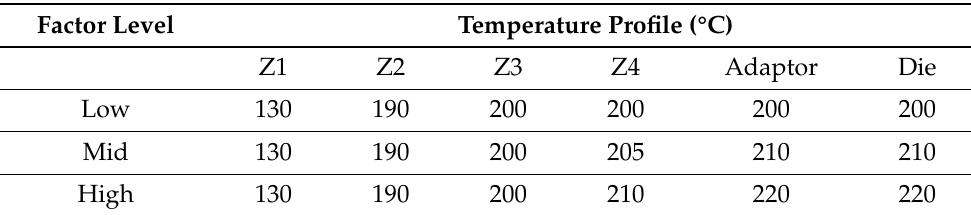
Table 1. Factor levels for the temperature profile in runs 1–24 (used in training).